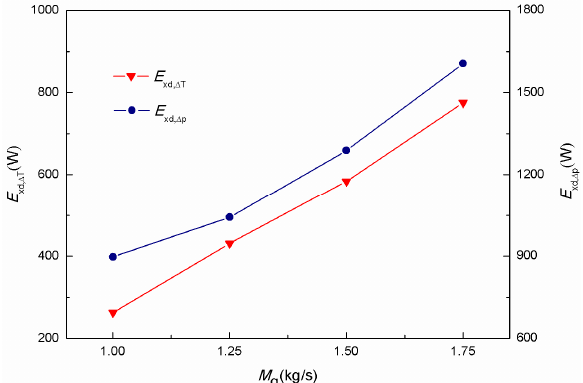
Figure 8. The distributions of the local heat transfer exergy destruction rate of sinter for different air mass flow rates.